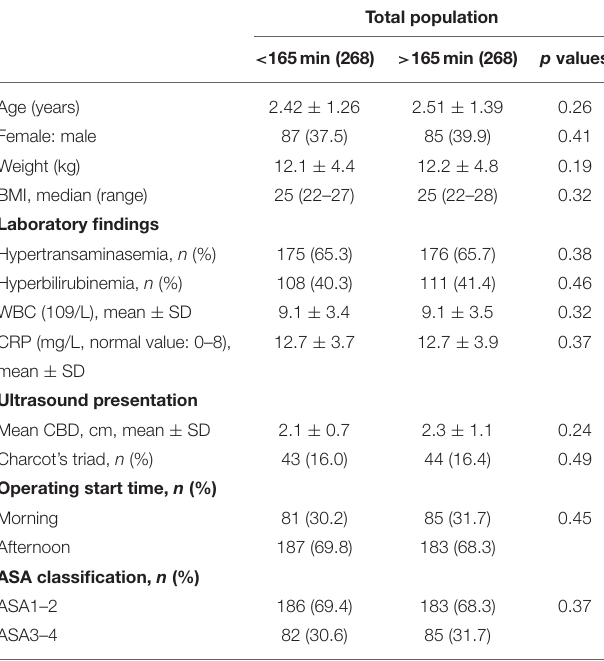
TABLE 3 | The inclusion variables in the PS-matching